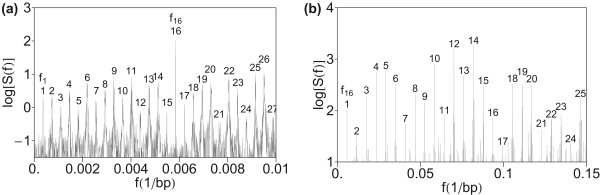
Power spectrum of HOR domain in AC017075.8 computed by using quartic mapping (Eq. 6). (a) Low-frequency section f < 0.01 bp-1. Equidistant peaks above the background of noise are assigned consecutively by integers 1, 2, 3, ... The fundamental frequency of peak no. 1 is denoted by f1. Frequencies of the peaks no. 2, 3, ... are denoted by f2 = 2·f1, f3 = 3·f1, ..., respectively. (b) Medium frequency section up to f = 0.15 bp-1. Pronounced equidistant peaks above the background of noise are assigned consecutively by integers 1, 2, 3, ... The frequency of monomeric peak no. 1 is the HOR peak at frequency f16 = 16·f1 from Figure 1a). Frequencies of monomeric peaks no. 2, 3, ... are 2·f16 = 2·16f1, 3·f16 = 3·16f1, ..., respectively (in terms of fundamental HOR frequency f1 from Figure 1a). The noise level is such that the monomeric peaks at frequencies nf16 are clearly seen above the background.